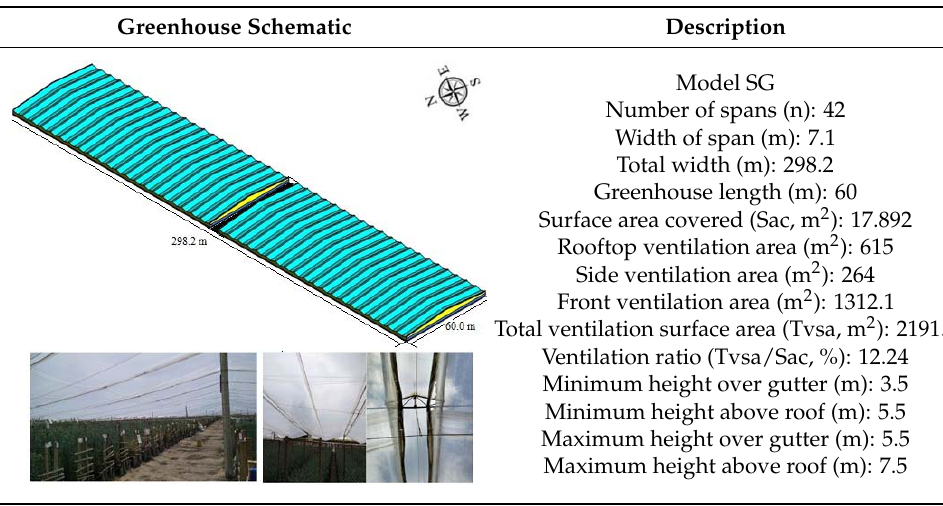
Table 5. General characteristics of the SG greenhouse.